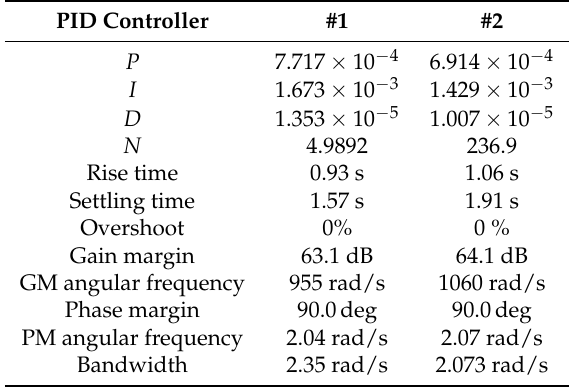
Table 5. Evaluation of different error terms of simulated